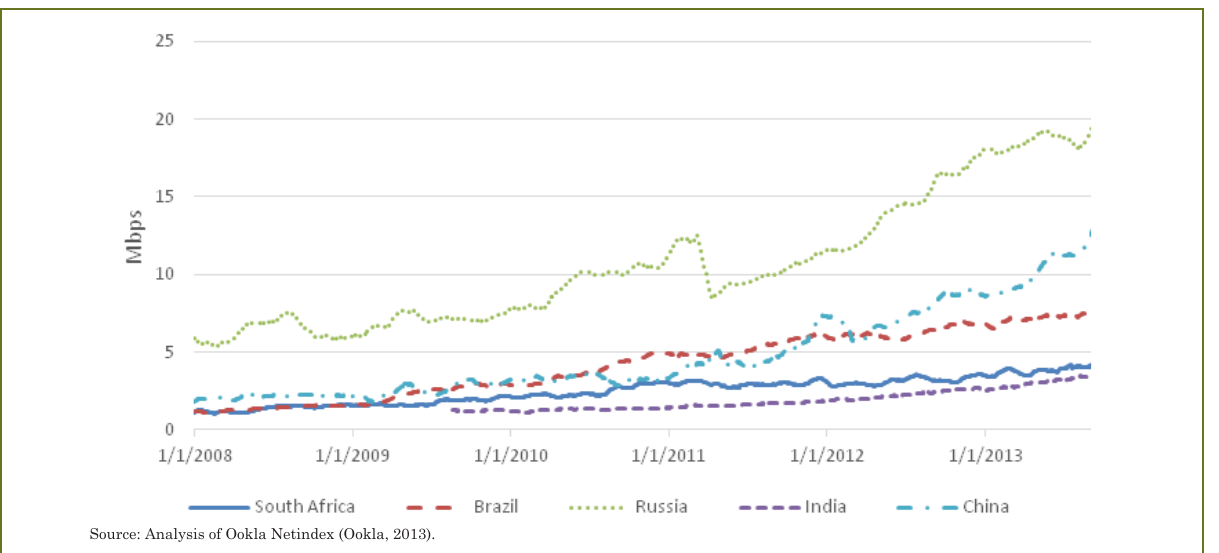
Source: Analysis of Ookla Netindex (Ookla,